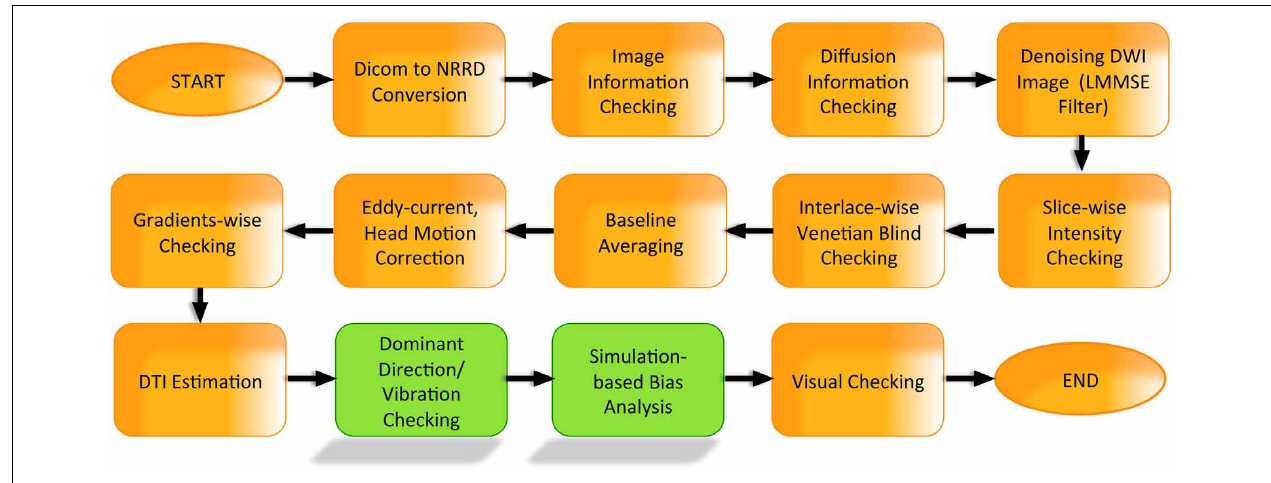
FIGURE 5 | DTIPrep